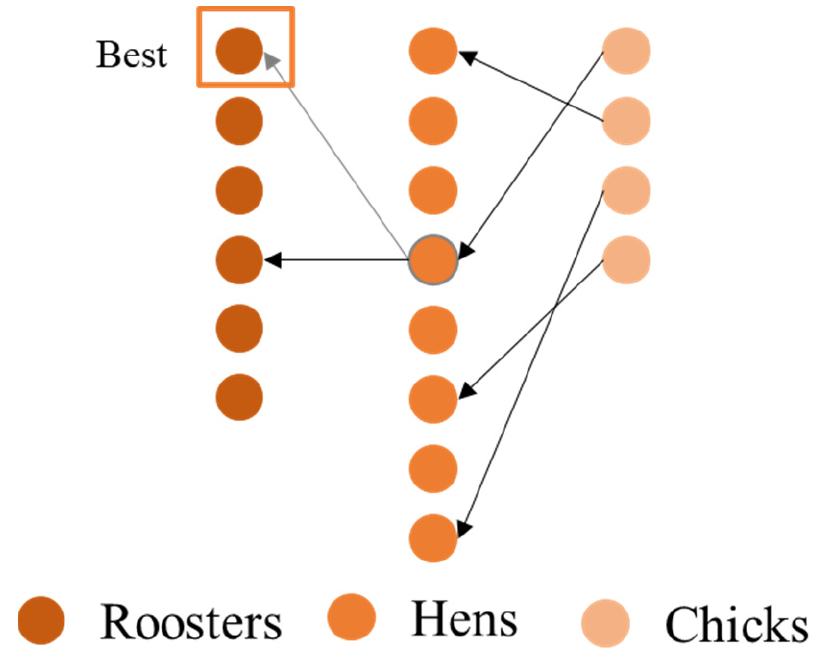
Figure 4. Double rooster-following strategy.